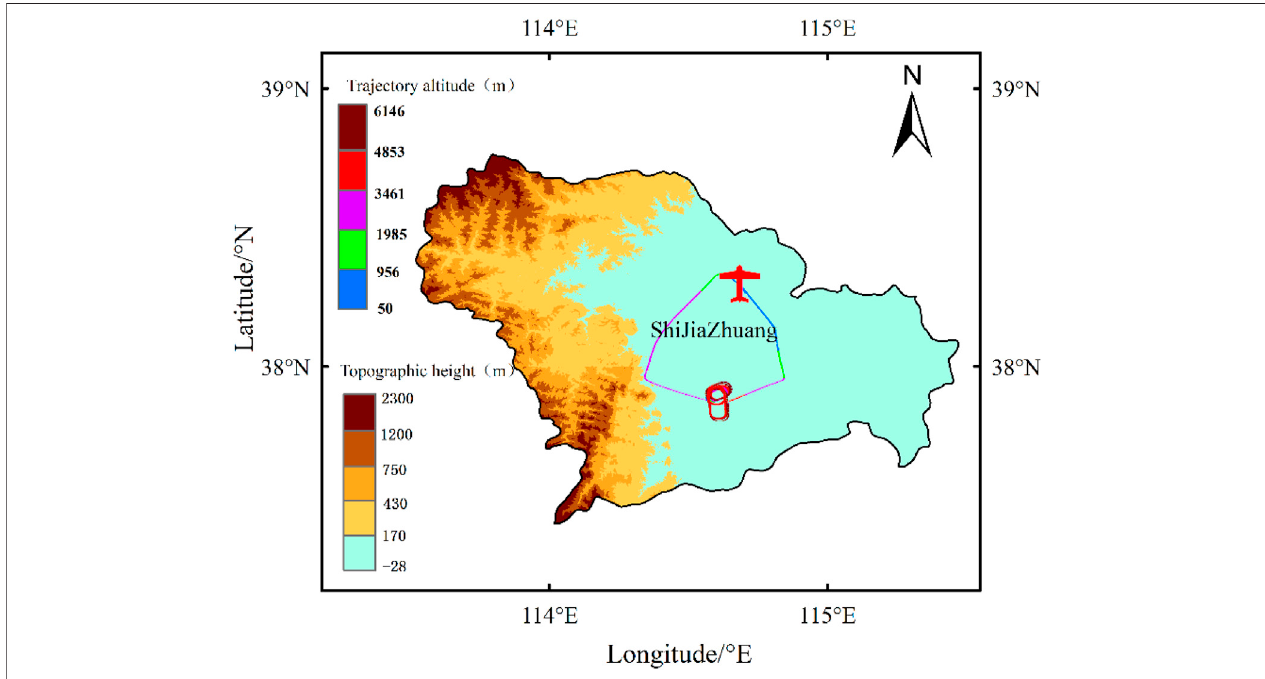
FIGURE 1 | The altitudinal terrain and fl ight trajectory in the experiment zone on May 15, 2021.